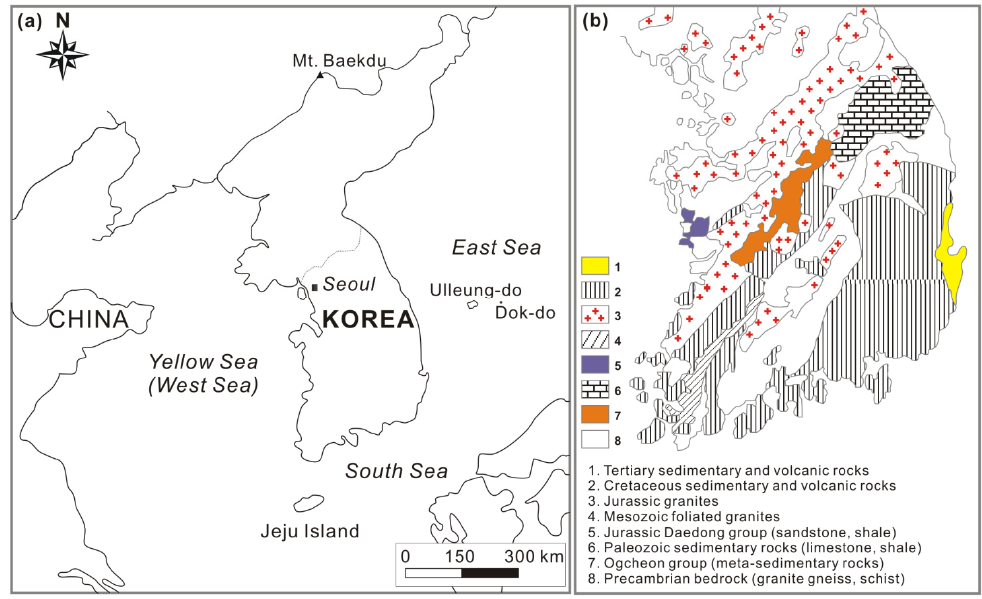
Figure 1. Location of the Republic of Korea and its simplified geologic map (modified from [3]).